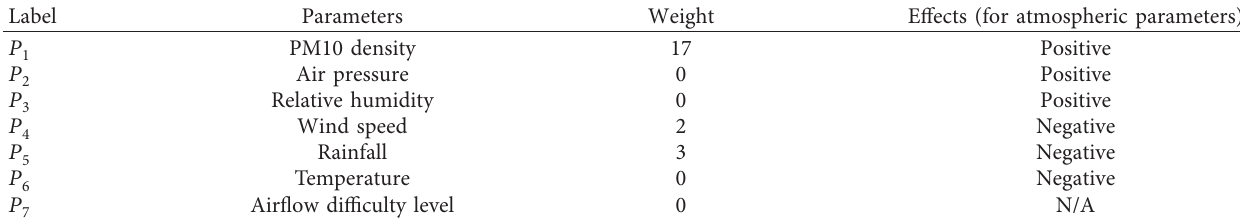
Table 14: Parameters and optimum weights for the haze warning system.